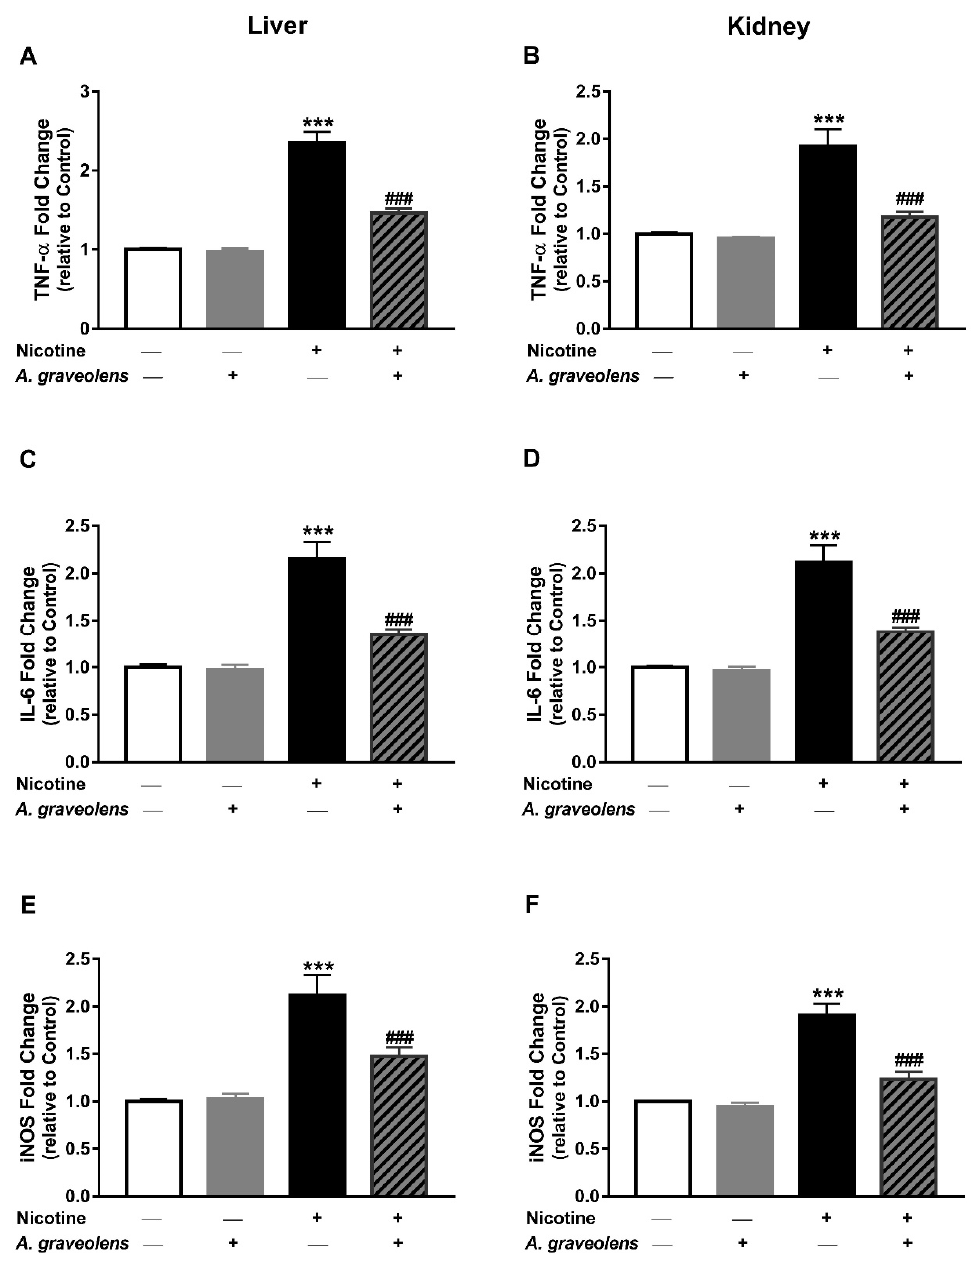
Figure 7. A. graveolens decreased tumor necrosis factor (TNF-α), interleukin-6 (IL-6) and inducible nitric oxide synthase (iNOS) mRNA abundance in liver and kidney of nicotine-exposed mice newborns. Data are mean ± SEM, n = 8. *** p < 0.001 versus Control and ### p < 0.001 versus nicotine: ( A ) Liver TNF-α; ( B ) Kidney TNF-α; ( C ) Liver IL-6; ( D ) Kidney IL-6; ( E ) Liver iNOS; ( F ) Kidney iNOS.